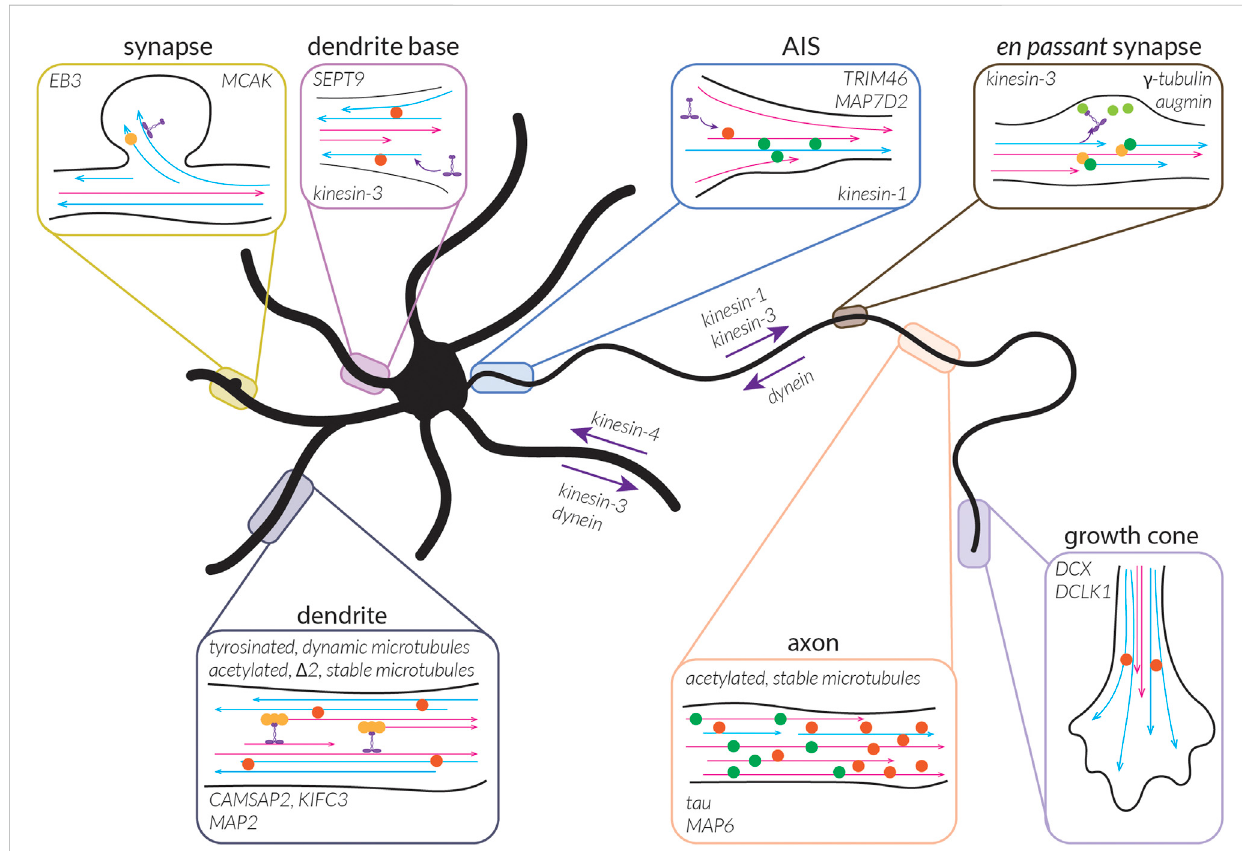
A map of the neuronal microtubule cytoskeleton and associated factors. The neuronal microtubule cytoskeleton is organized into a spectacularly asymmetric arraycomposed oftwomain subsetsofmicrotubules:stable anddynamic(indicatedbymagentaand cyanlines, respectively).Their stability/ dynamicity, motility, organization, and nucleation are controlled by a variety of MAPs, some of which are shown here at the site within the neuron where they are believed to serve an important role. The subdivision of the microtubule cytoskeleton into these subsets, along with their respective organization (and orientation), likely helps to control the transport of different cargoes by motor proteins, which thus serve as anterograde or retrograde motorsindifferentneuronalprocesses.Someofthese(including